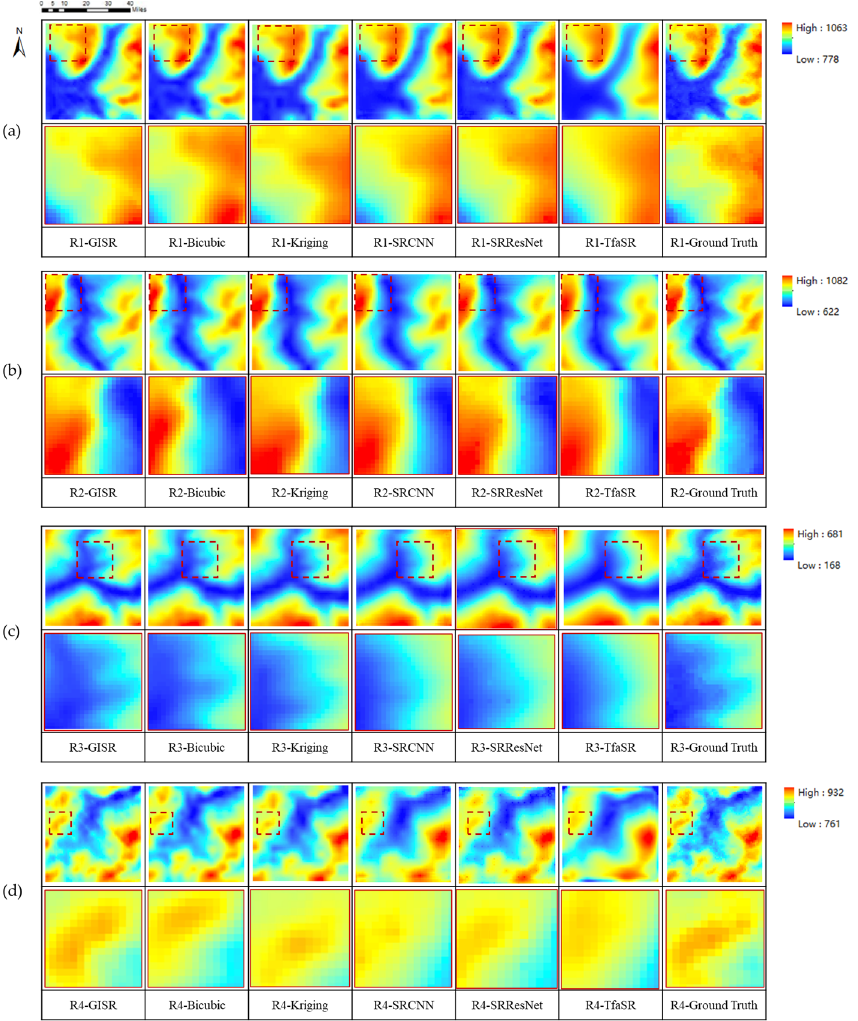
Figure 11. The DEM SR results of different methods in four test regions: ( a – d ) are the test regions R1, R2, R3, and R4, respectively (The contents of the solid wireframe are the enlarged details of the dotted wireframe).